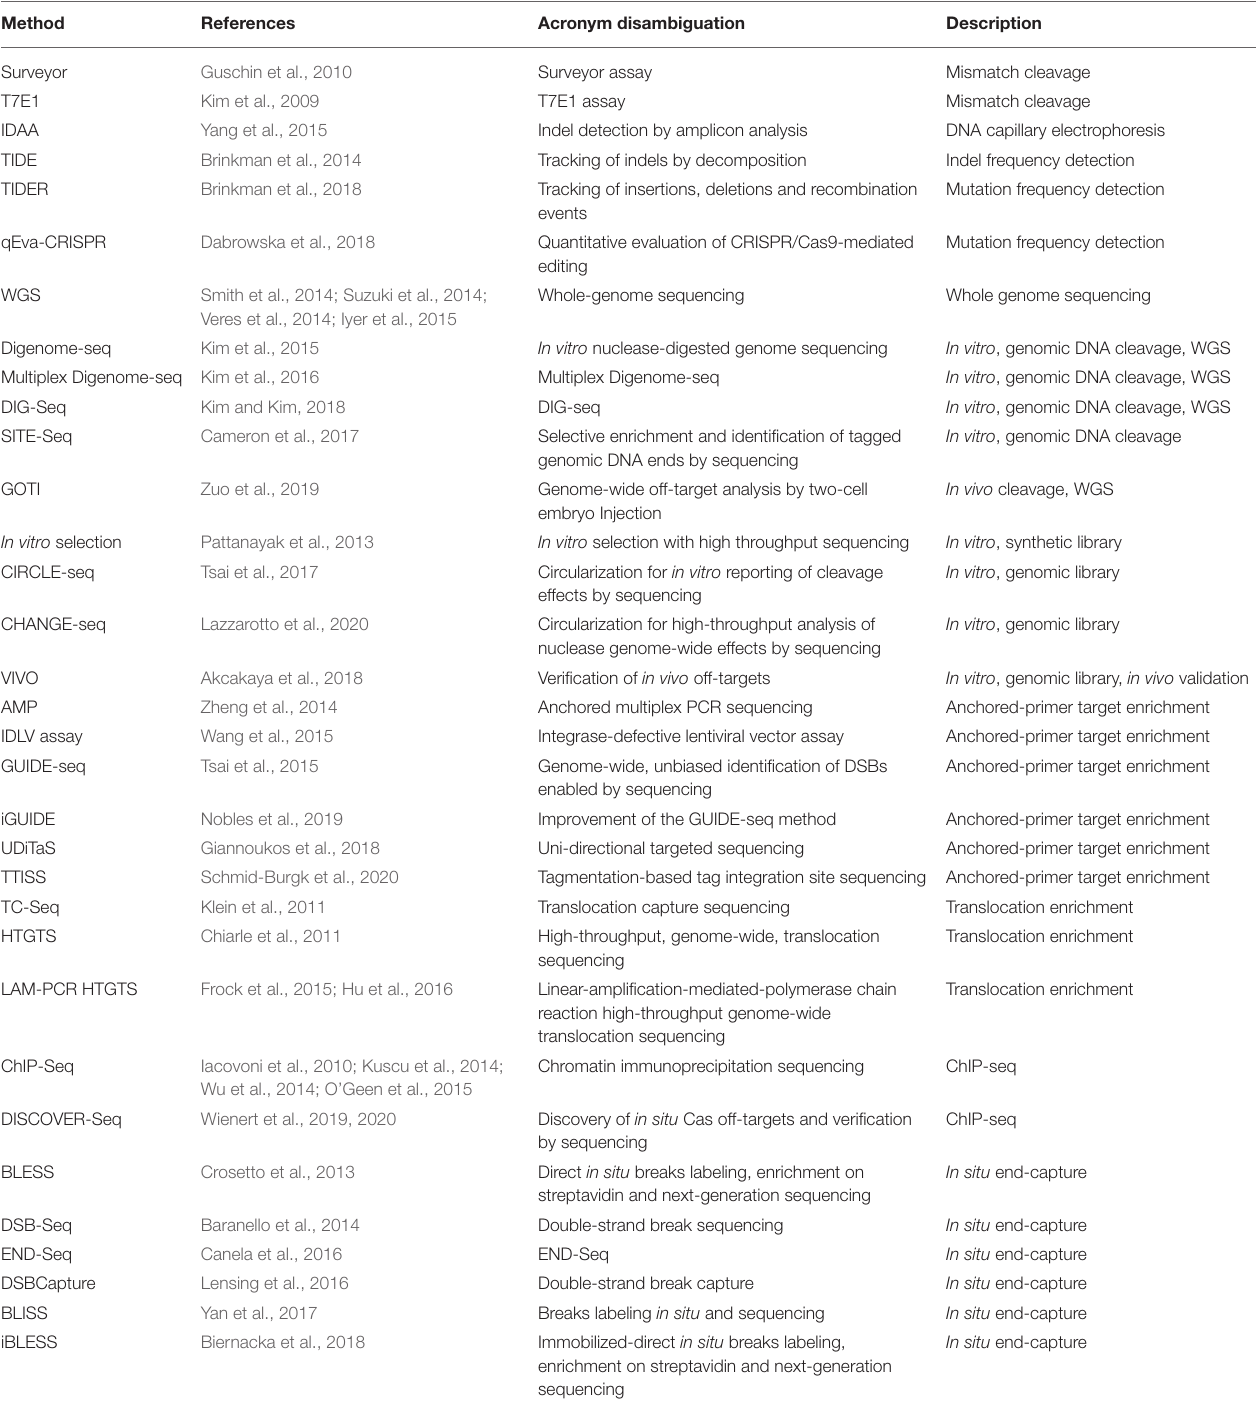
TABLE 1 | Methods for detection of off-target CRISPR